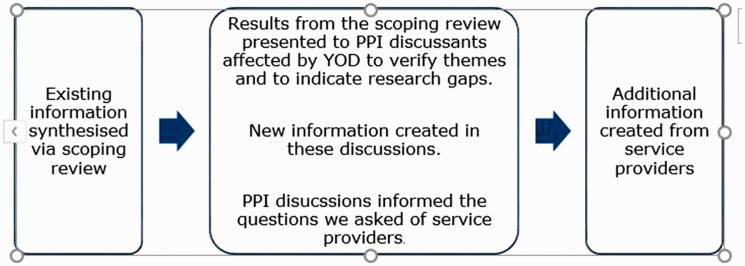
The role of PPI discussion groups.